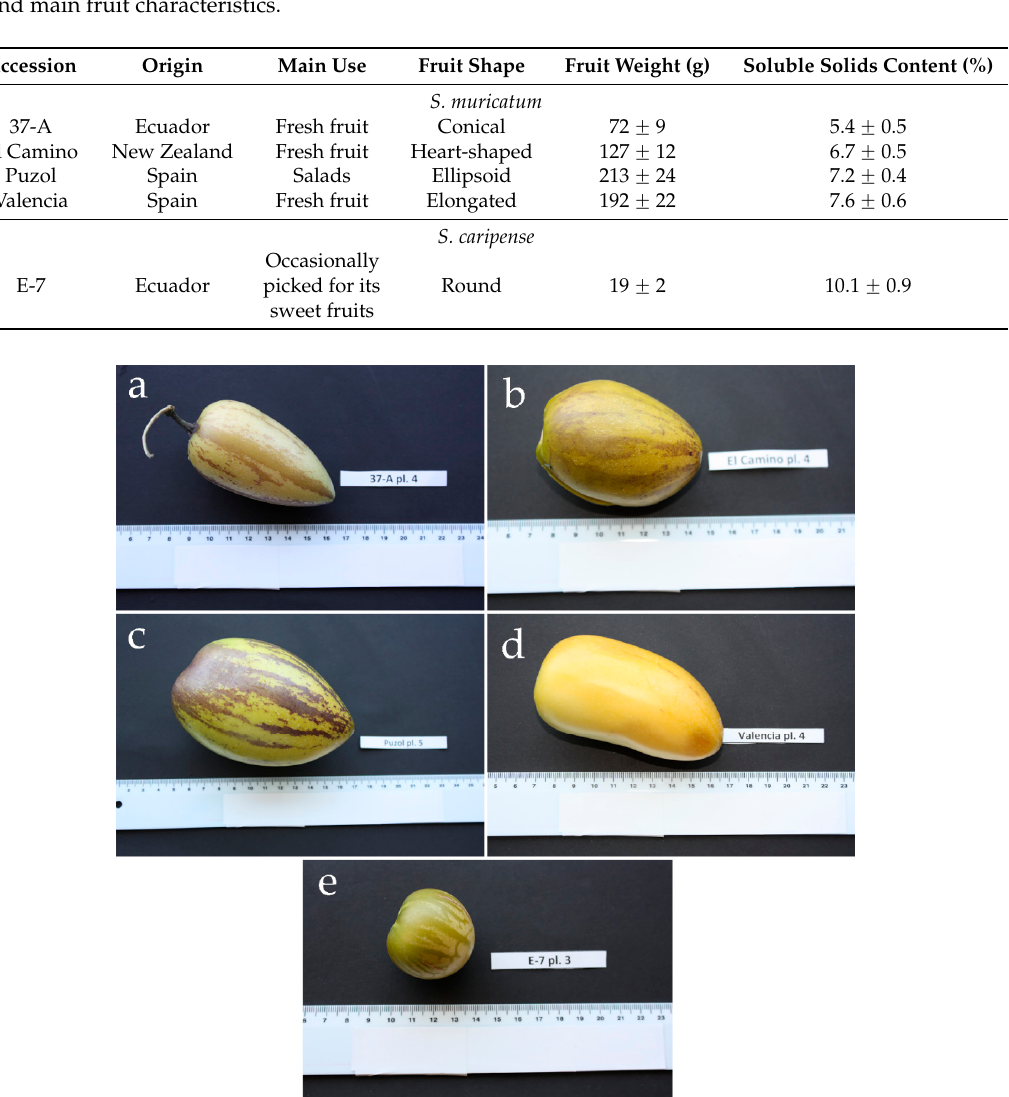
Figure 4. Fruit samples of the pepino ( S. muricatum ) and S. caripense accessions used. Pepino varieties correspond to 37-A ( a ); El Camino ( b ); Puzol ( c ); and Valencia ( d ); while S. caripense accession is E-7 ( e ). Scale is in cm. The plant (pl.) replicate from which samples were obtained is indicated.